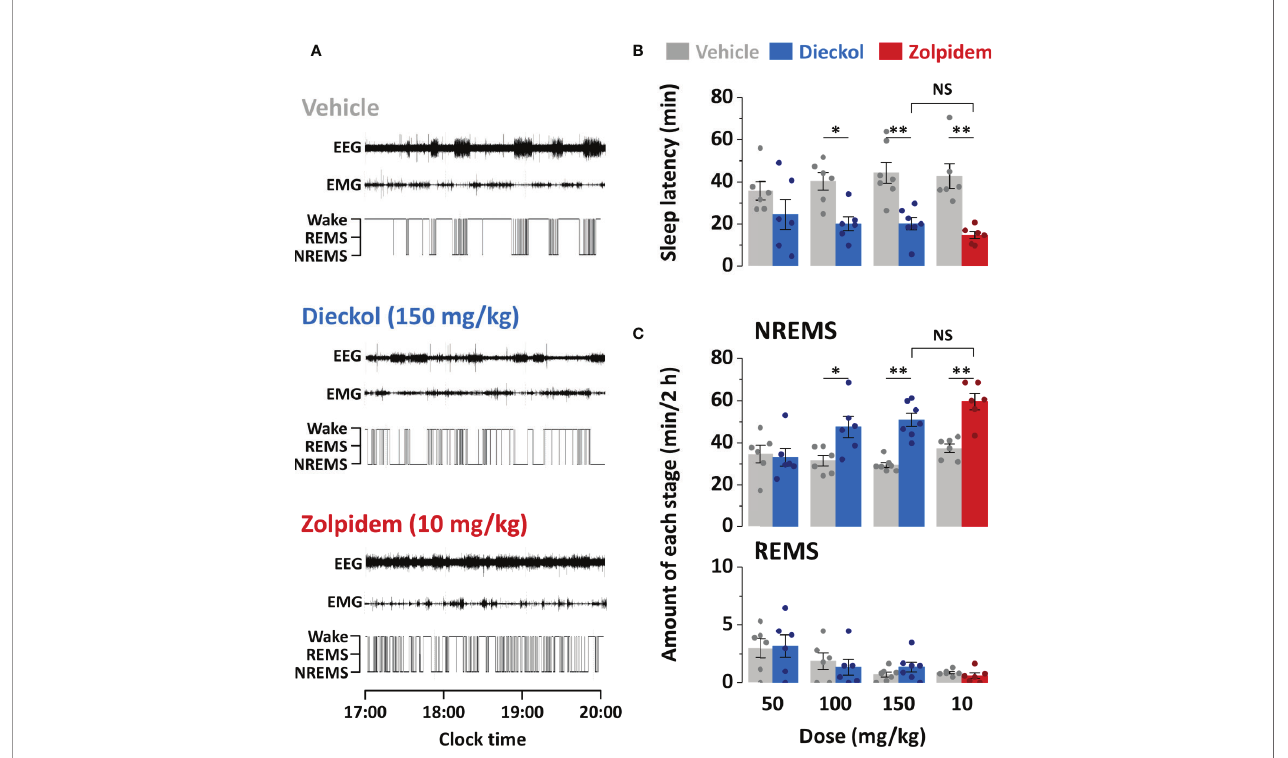
FIGURE 3 | Effect of dieckol and zolpidem on sleep-wake pro fi les in C57BL/6N mice. (A) Representative EEG and EMG signals, and corresponding hypnograms in a mouse treated with dieckol or zolpidem. (B) Effects of dieckol and zolpidem on sleep latency. (C) Amounts of NREMS and REMS during the 2 h period after administration of dieckol or zolpidem. Gray bars indicate the baseline day (vehicle administration). Each value represents the mean ± SEM of each group (n = 6 – 7) with data points. * p < 0.05 and ** p < 0.01, signi fi cant difference compared to the vehicle (paired Student ’ s t -test). EEG, electroencephalogram; EMG, electromyogram; NREMS, non-rapid eye movement sleep; NS, no signi fi cance; REMS, rapid eye movement sleep; Wake,